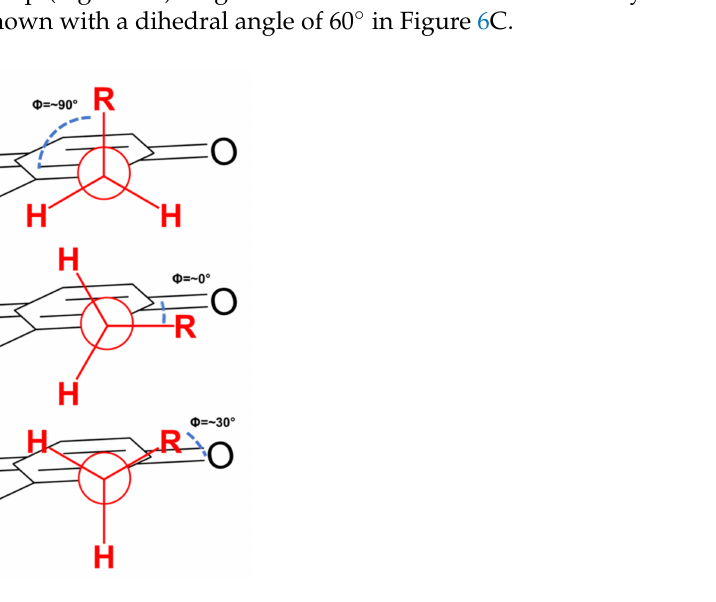
Figure 6. Newman projections of folded and flat conformations. ( A ) Folded conformation with a dihedral angle of approximately 90 ◦ . ( B ) Flat conformation with a dihedral angle of approximately 0 ◦ . ( C ) Gauche conformation with a representative dihedral angle of ~30 ◦ .